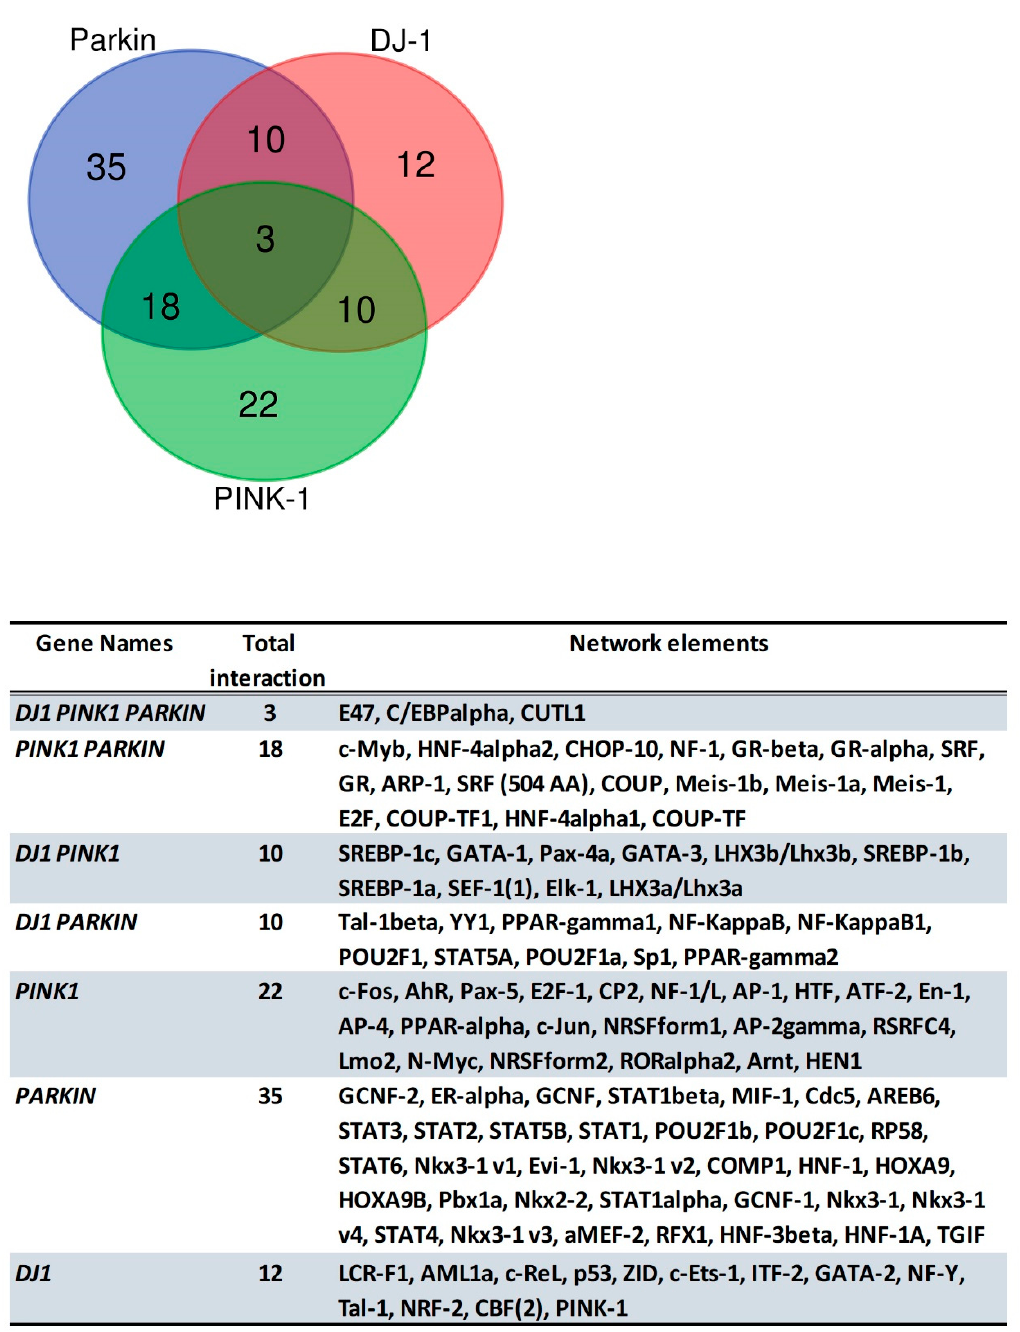
Figure 8. Venn diagram that presents all possible logical relations between the predicted transcription factors for the PINK, PARKIN and PARK7. The diagram was created with the Bioinformatics and Evolutionary Genomics